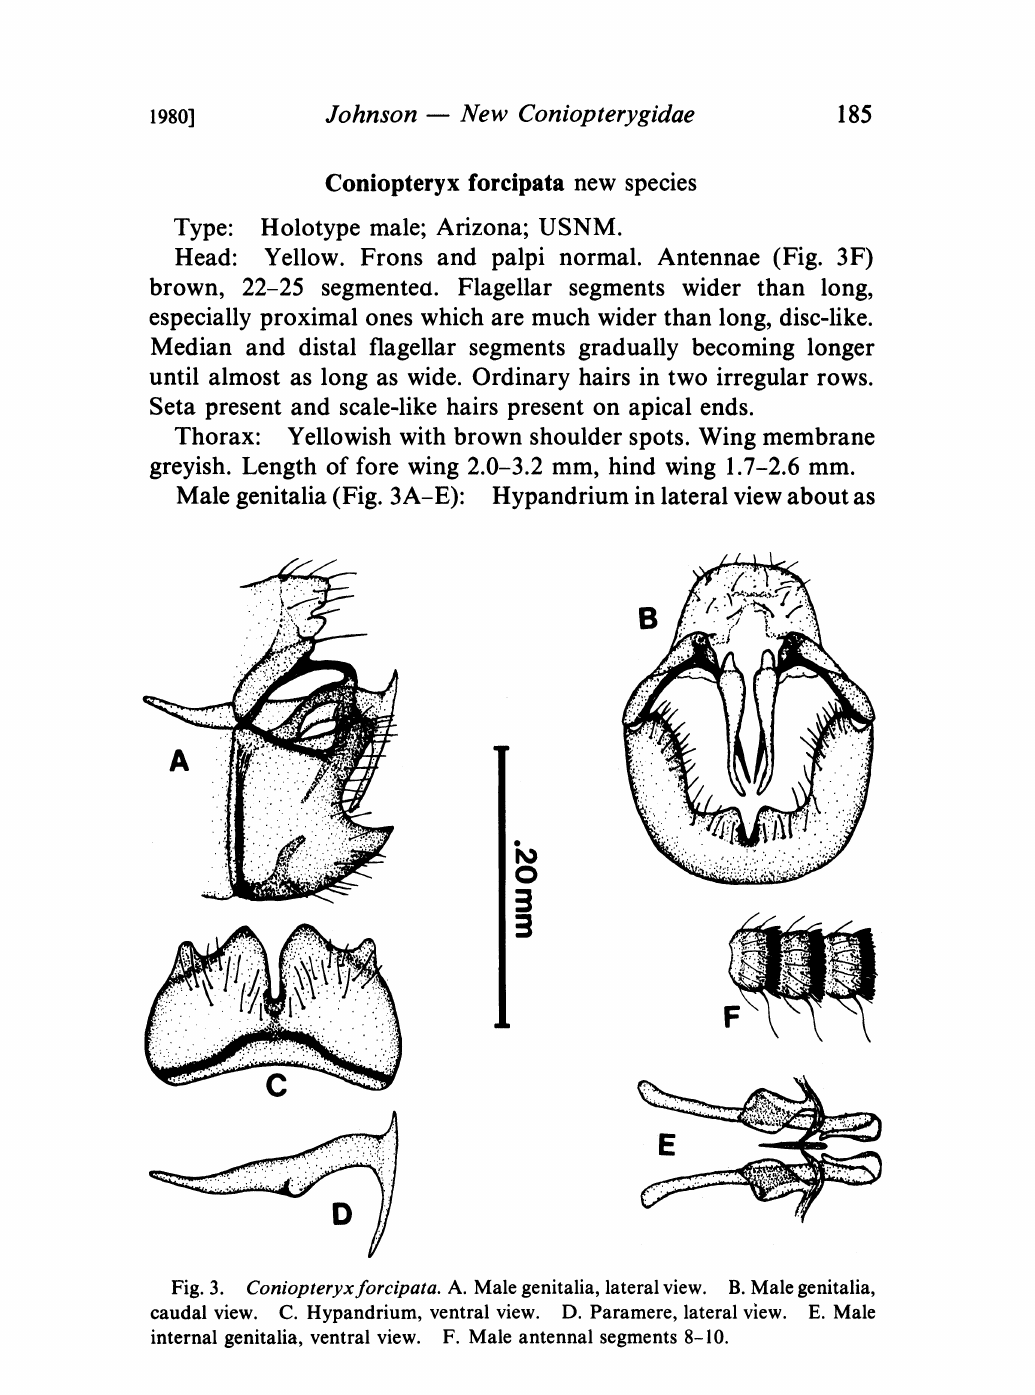
Fig. 3. Coniopteryxforcipata. A. Male genitalia, lateral view. B. Male genitalia, caudal view. C. Hypandrium, ventral view. D. Paramere, lateral view. E. Male internal genitalia, ventral view. F. Male antennal segments